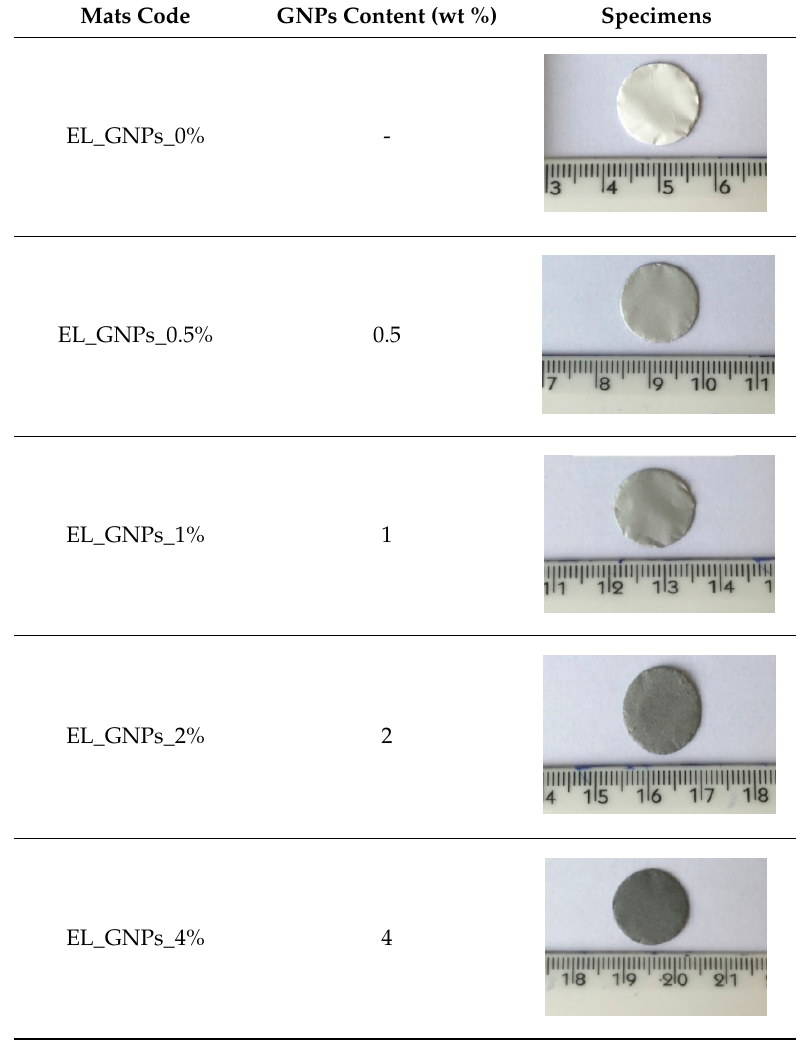
Table 1. Samples codes, graphene nanoplatelets (GNPs) content (wt %) and representative images of the electrospun matrices.